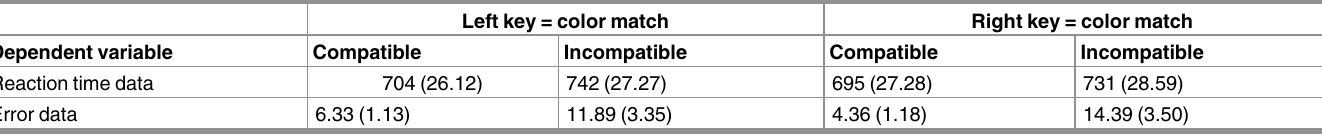
Table 2. Mean response latencies (in ms) and mean error rates (in percentages) as a function of response assignment and compatibility in Experi- ment 3 ( SE in parentheses). Left key = color match Right key = color match Dependent